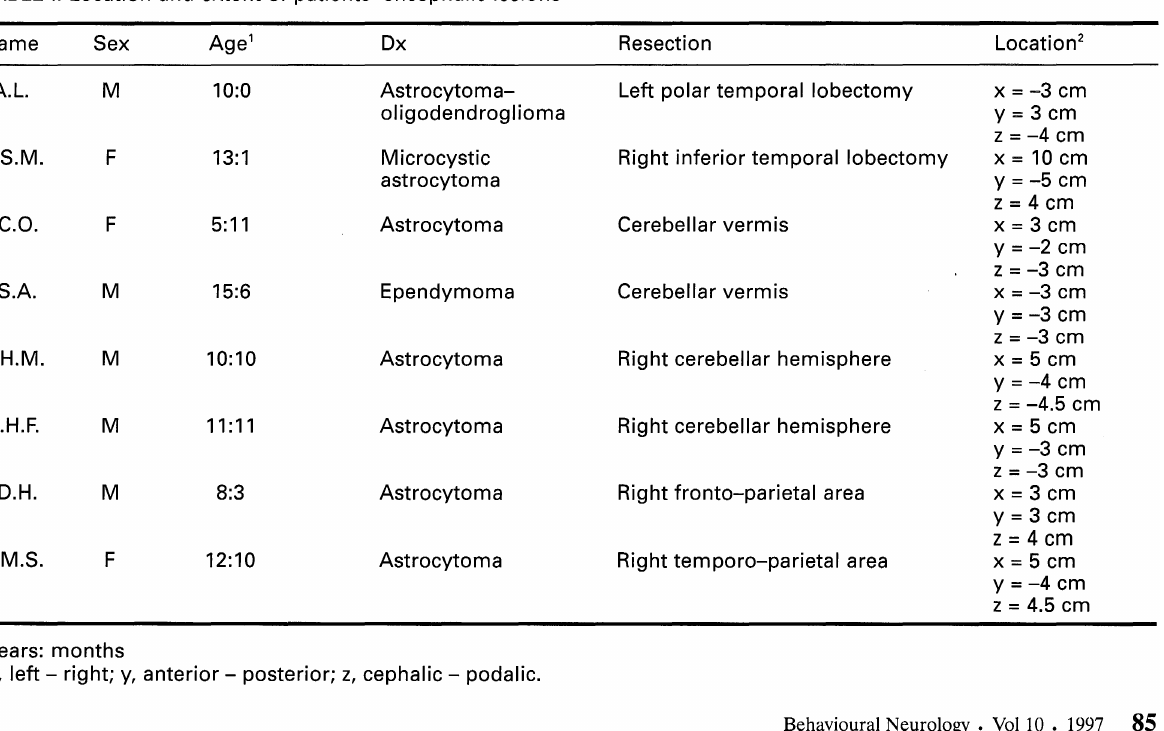
TABLE I. Location and extent of patients' encephalic lesions